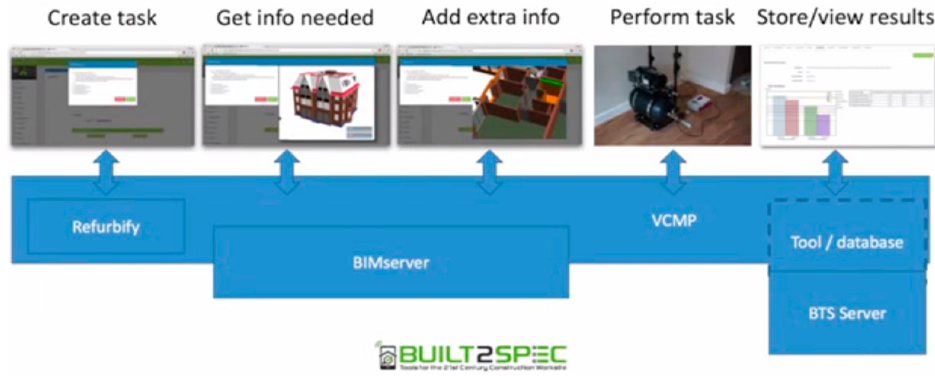
Figure 2. Workflow representation in VCMP to perform Air Pulse test on